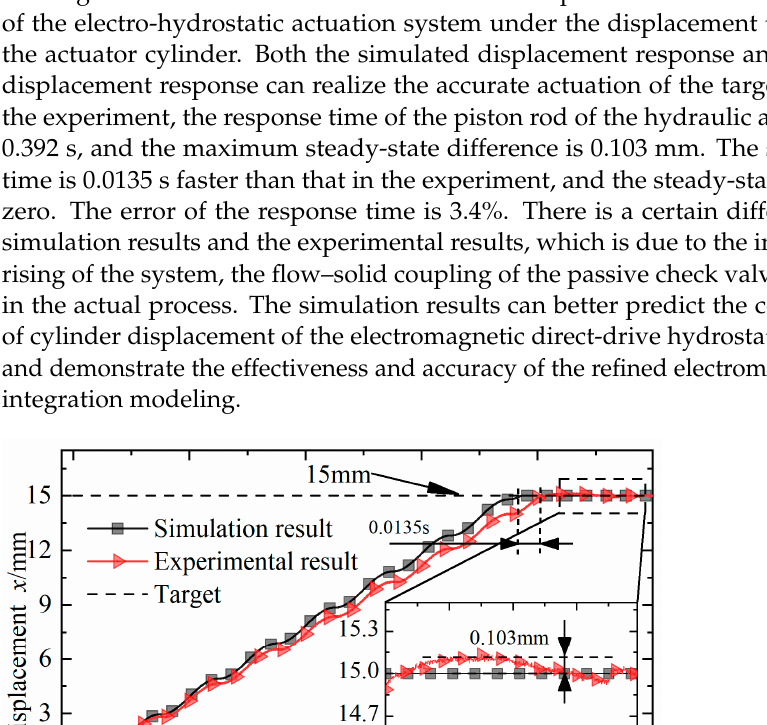
11 of 13 Figure 10. Response curve of instantaneous flow. Due to the fitting clearance of the plunger friction pair and the high and low pressure difference between the two ends of the piston sealing surface, the electromagnetic direct- drive piston pump has internal leakage, the electromagnetic direct-drive piston pump has internal leakage and the peak flow is less than 0.005 L/min. At the end of the pumping